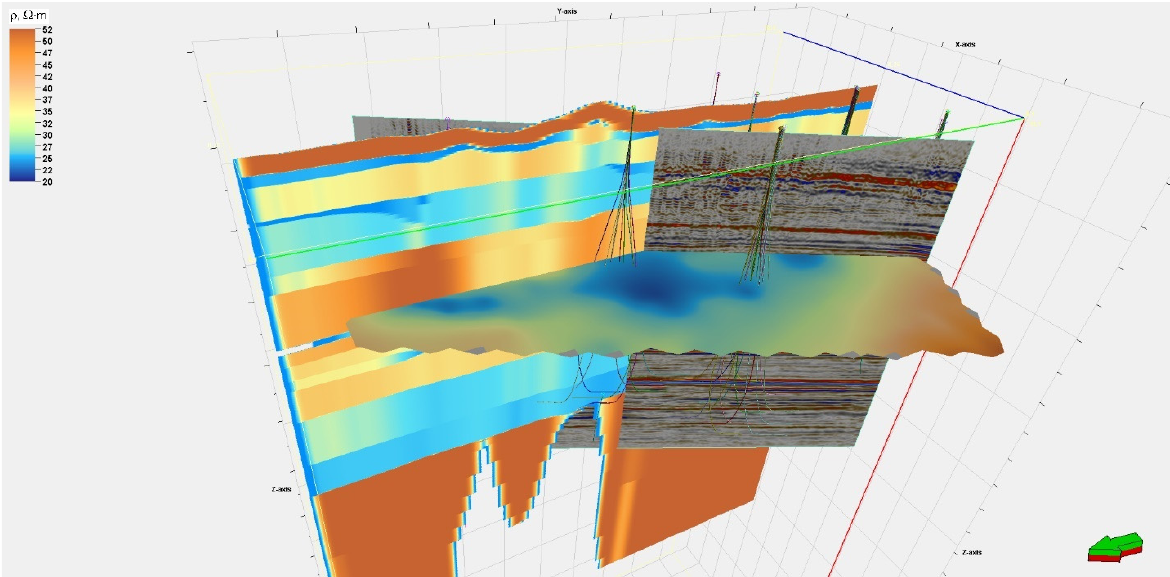
Figure 6. Example 3D seismic-resistivity model (East Siberia).